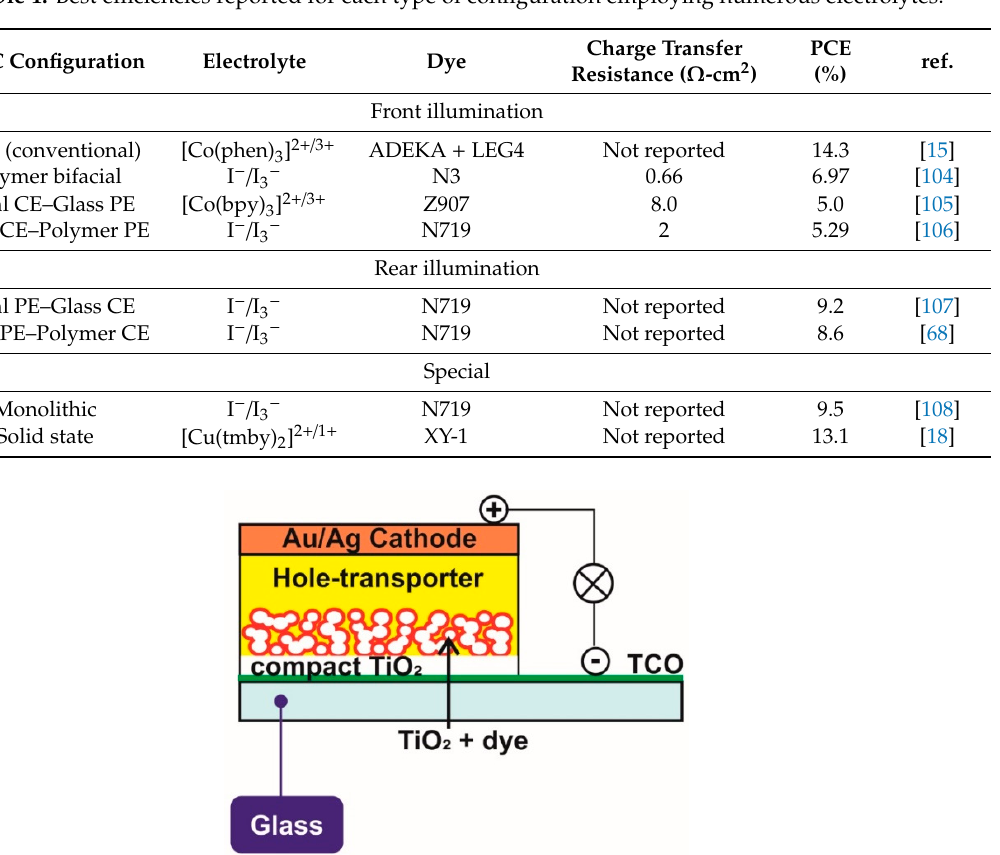
Table 1. Best e ffi ciencies reported for each type of configuration employing numerous electrolytes.